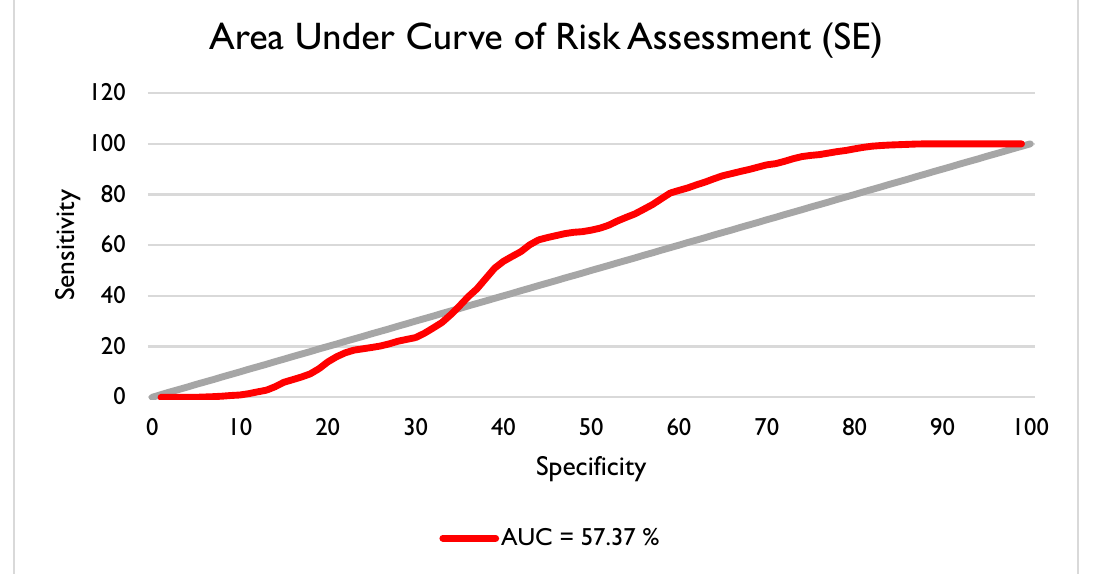
Figure 18. Area Under the Curve conducted for risk assessment created from SE.